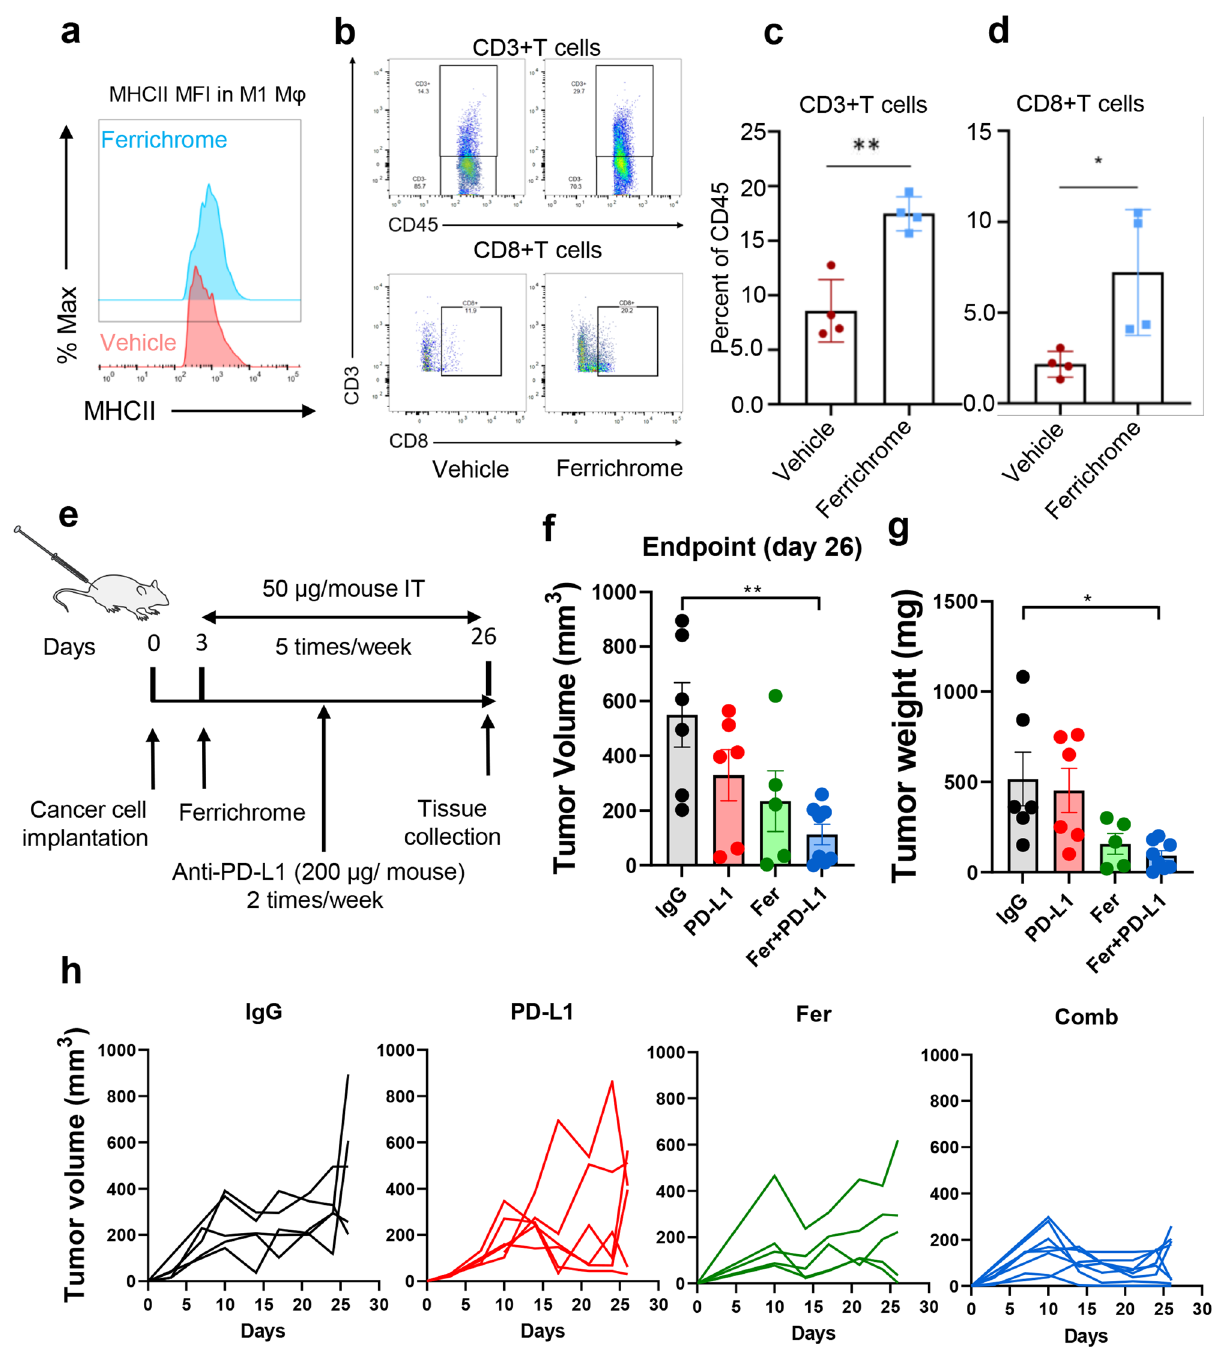
Fig. 7 Ferrichrome promotes CD8 + T cell in fi ltration in pancreatic tumors and improves anti-PD-L1 therapy. a Representative histogram comparing MHCII MFIs in M1-like macrophages (gated CD45 + CD11b + Ly6C − Ly6G- F4/80 + MHCII-high) of tumors treated with ferrichrome (cyan) or vehicle (red) as determined by fl ow cytometry analysis ( n = 3 mice). b Flow cytometry analysis of the frequency of ( c ) total T cells (CD3 + ) and ( d ) CD8 + T cells in tumors treated with ferrichrome (blue) or vehicle (maroon) ( n = 4 mice). e Schematic representation of combination treatment regimen of ferrichrome and anti-PD-L1 of UN-KC-6141 syngeneic mouse model. Ferrichrome was given fi ve times per week starting at day 3 while anti-PD-L1 (200 µ g/mouse) was given twice per week starting at day 5. Tumors were resected at day 26 ( n = 5 – 8). Graph representing mean values of ( f ) tumor volume at endpoint, ( g ) tumor weight and ( h ) tumor volume of individual mice per treatment group. Mean± SEM shown. * p < 0.05, and ** p < 0.01, and *** p < 0.001 as determined by Student ’ s t test for T cell analysis and one-way ANOVA for combination